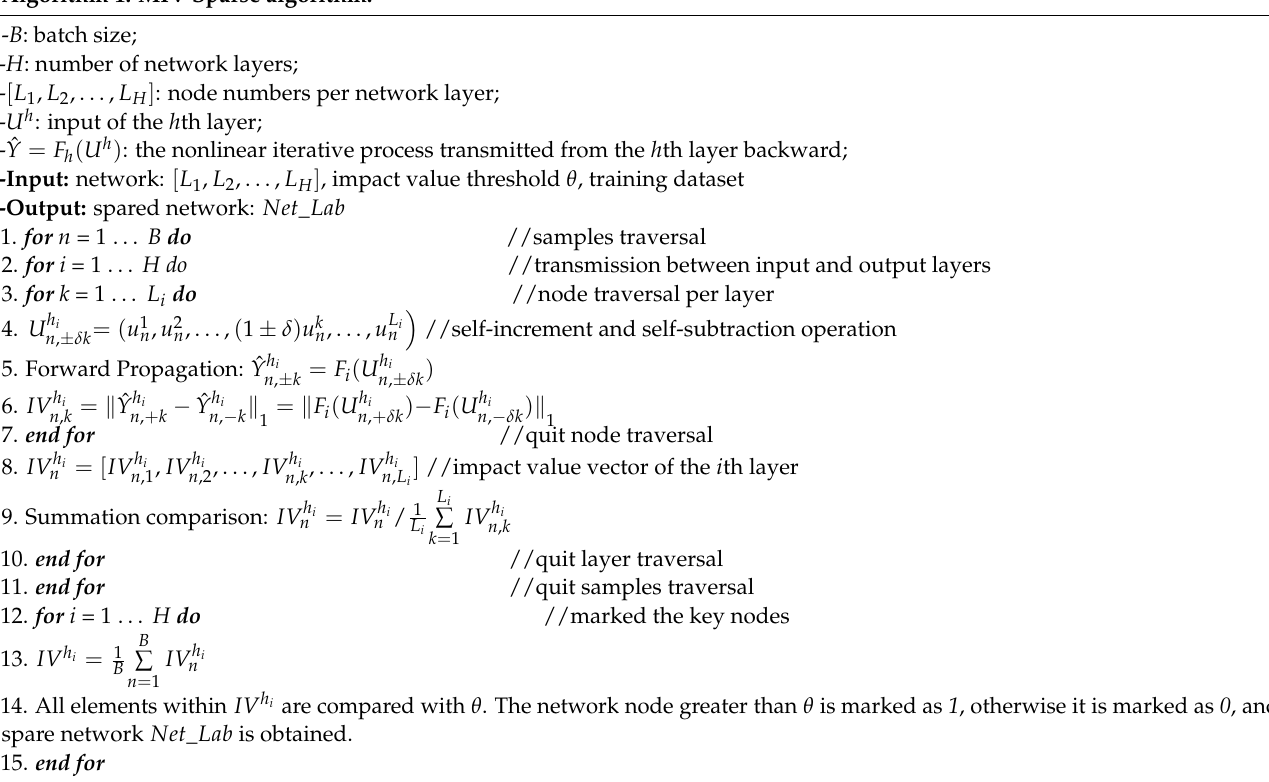
Algorithm 1: MIV-Sparse